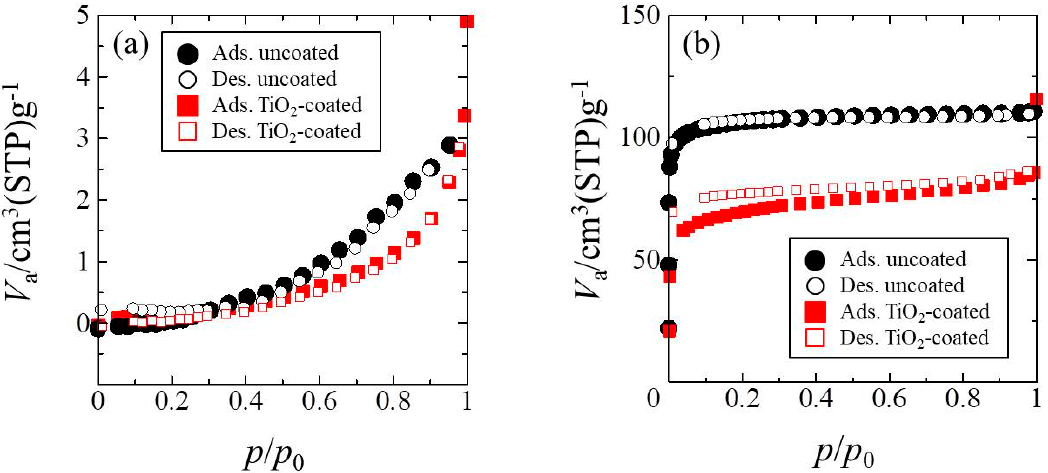
Figure 5. Adsorption (Ads.) and desorption (Des.) isotherms of ( a ) a non-porous glass cloth and ( b ) a porous glass cloth before and after TiO 2 coating.